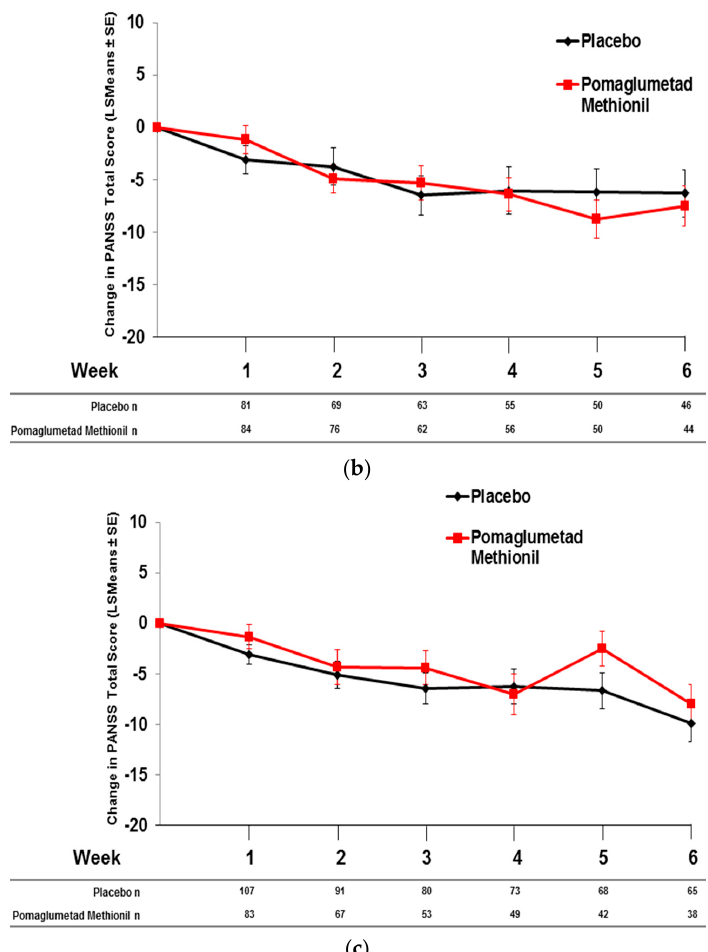
Figure 7. Integrated analysis; change in PANSS total score by HTR2A SNP rs7330461 genotype in Caucasian patients treated with pomaglumetad methionil versus placebo; data from Studies 3 and 5. ( a ) T/T homozygous patients. ( b ) A/T heterozygous patients. ( c ) A/A homozygous patients. Abbreviations: HTR2A = serotonin 2A receptor ( HTR2A ) gene; LSMeans = least squares means; n = number of patients with PANSS measures; PANSS = Positive and Negative Syndrome Scale; SE = standard error; SNP = single nucleoside polymorphism.